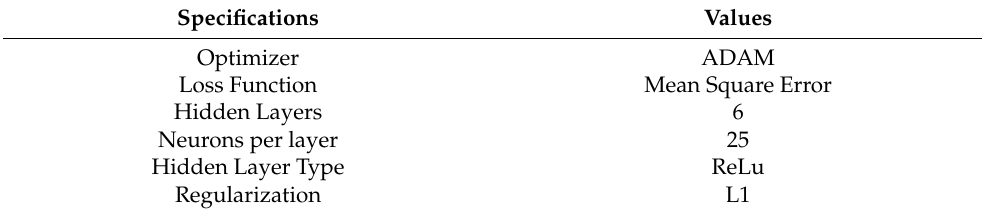
Table 1. NN specifications